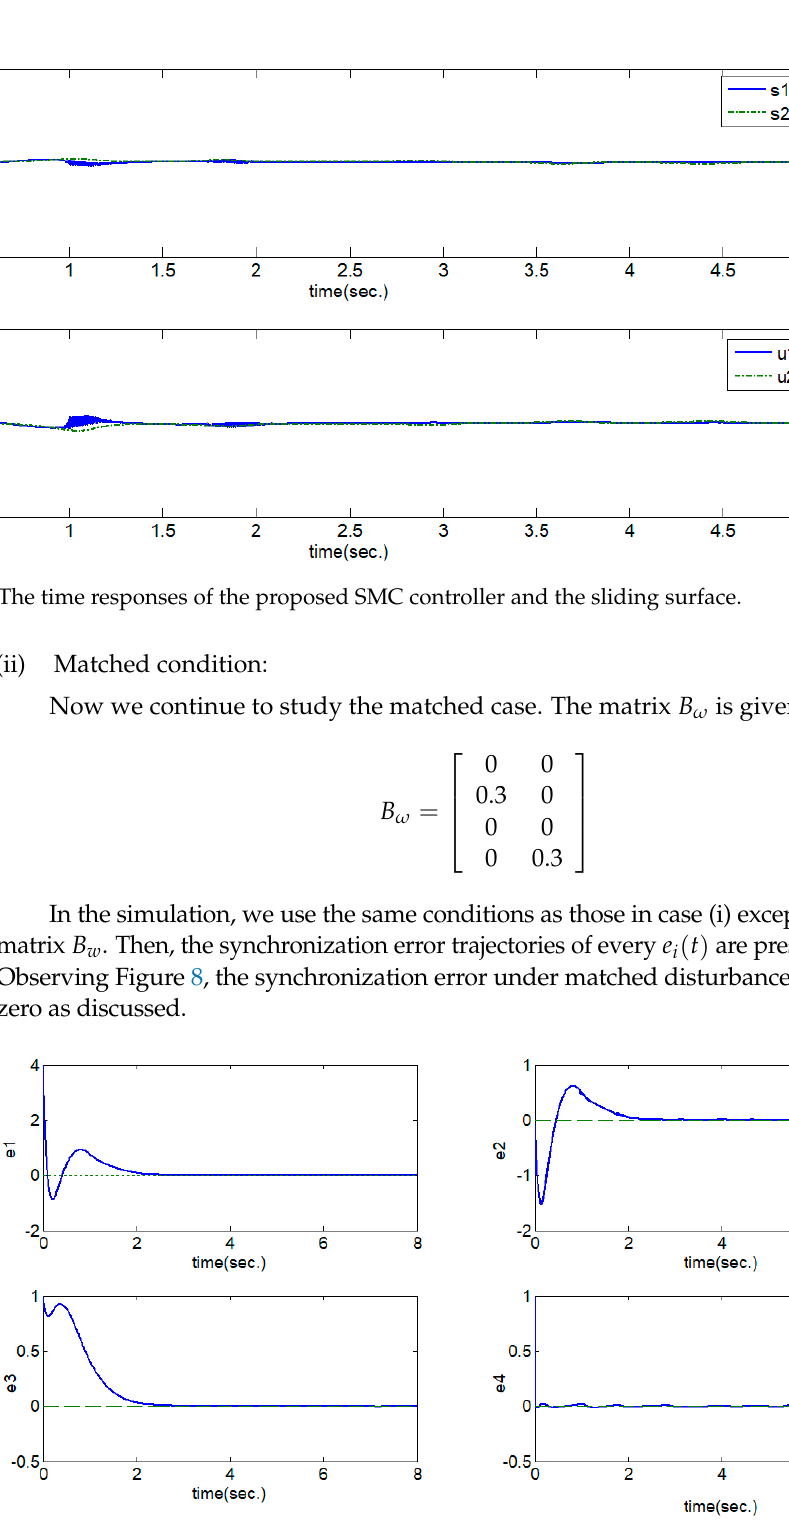
Figure 8. The synchronization error responses (matched condition).